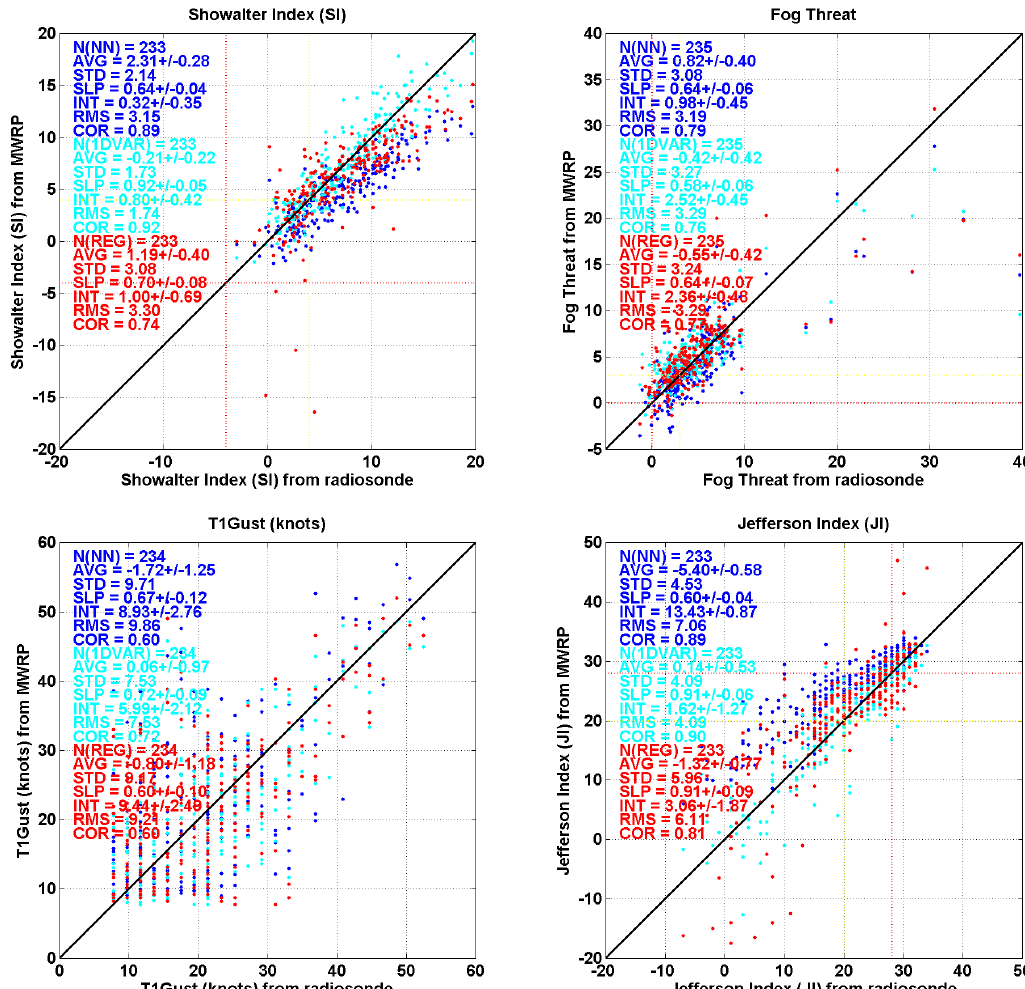
Figure 12. As in Fig. 9 but for (clockwise from top-left panel) Showalter index, fog threat, T1 gust, and Jefferson index. Dotted yellow and red lines indicate thresholds for moderate and high potential, respectively (where